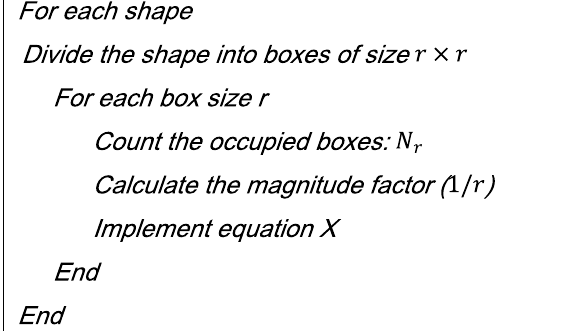
Table 1. Pseudocode for the box-counting approach for calculating fractal